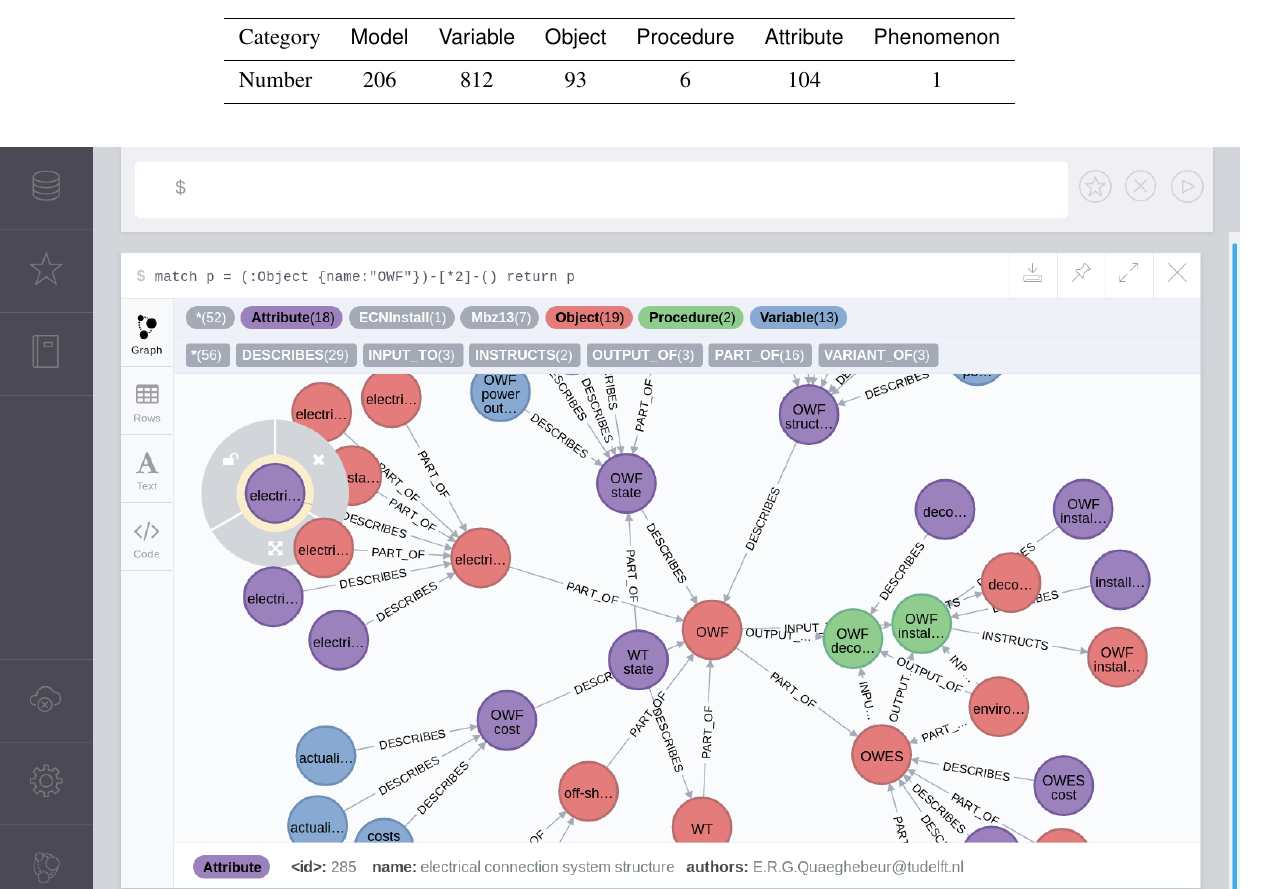
Figure 3. A screenshot of the Neo4j web